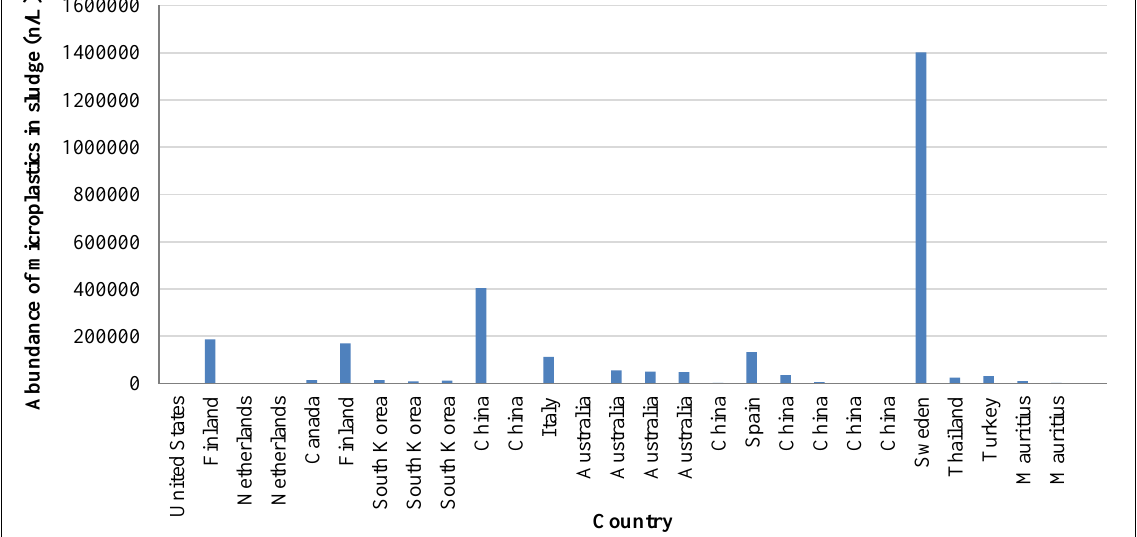
Figure 4. Abundance of microplastics in the sludge of WWTPs by